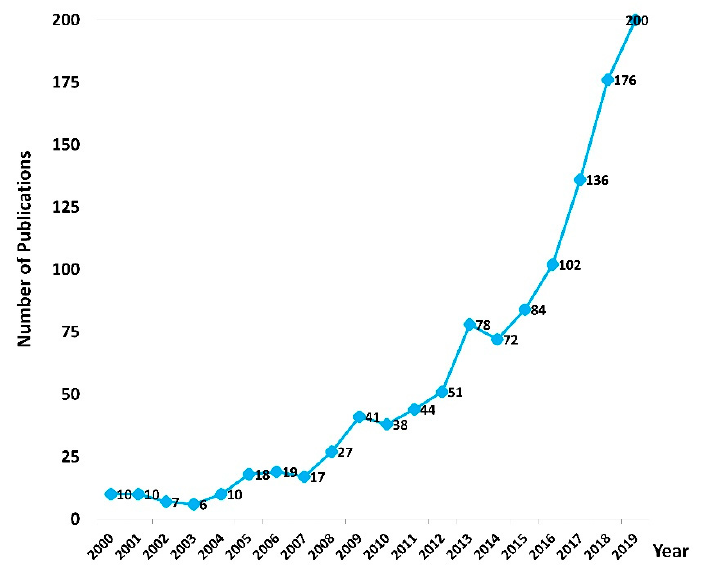
Figure 1. Number of publications investigating moxibustion by year over the past 20 years.